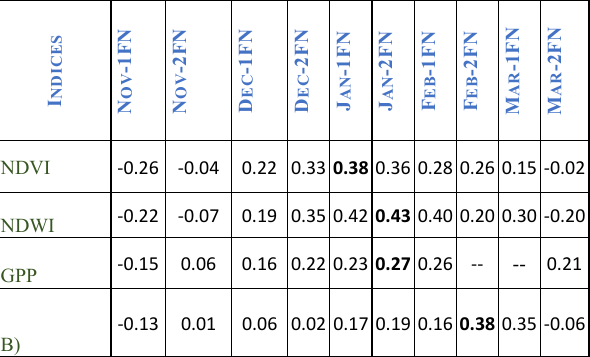
Table 4 Temporal correlation between Indices and wheat grain yield